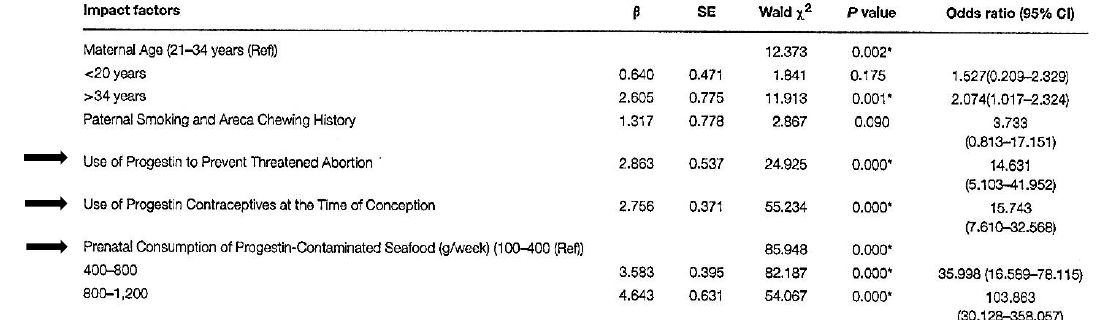
*, indicates signi fi cant differences; #, during the fi rst trimester of pregnancy; df, degrees of freedom (a) Potential impact factors of progestin exposurefor ASD in a Chinese population-based case-control study. The three major exposure sources during pregnancy are indicated with black arrows. © Li et al. (12). (b) Multivariate regression analysis of the impact factors on ASD prevalence after progestin in-utero exposure. Note the high oddsratio for the three major progestin exposure sources (black arrows). © Li et al. (12). With